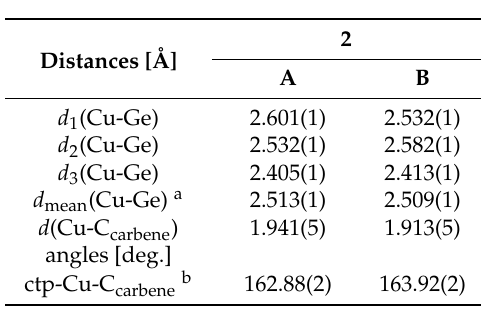
Table 2. Selected distances and angles in compound 2